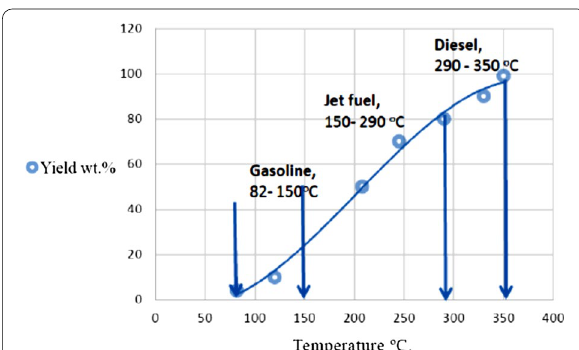
Fig. 3 Distillation fractions via %yield of the hydro catalytic cracking products